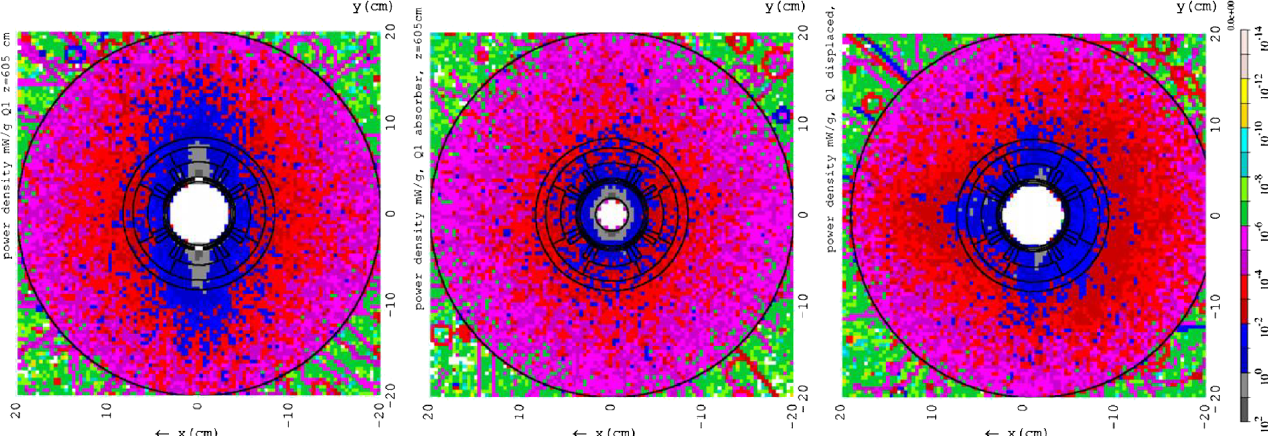
FIG. 6. Deposited power density in Q1 ( mW = g ) for three cases: standard (left), with absorbers inside (center), and with horizontal displacement (right). Larger radii are on the left of the plots.